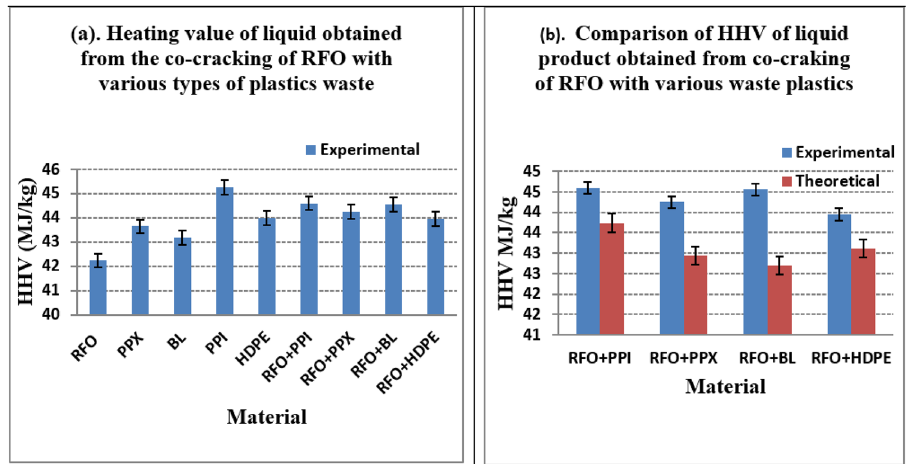
Figure 5. ( a ) Graphical representation of HHV values for the liquid obtained from the co-cracking of RFO with waste plastics, ( b ) Graphical representation of a comparison of theoretical and experimental HHV.